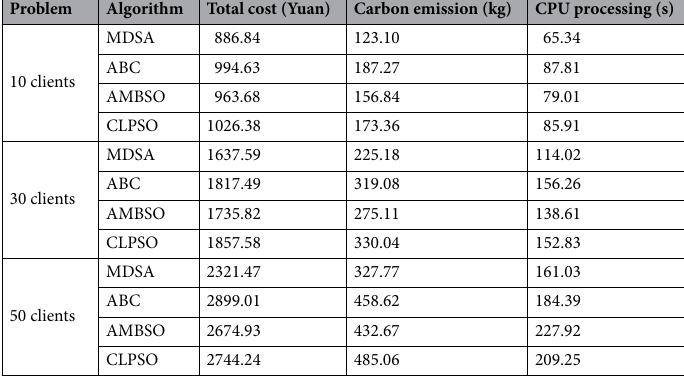
Table 2. The performances of different algorithms in solving TWMOPRP.